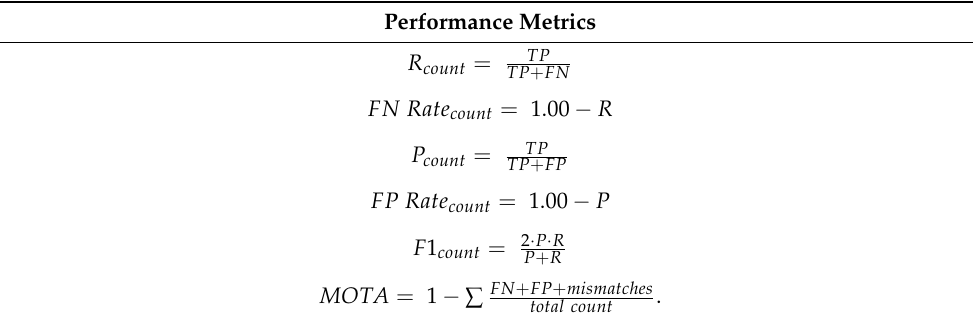
Table 5. The performance metrics used to evaluate the pear counting methods. This evaluation is based on the CLEAR MOT Challenge [45].